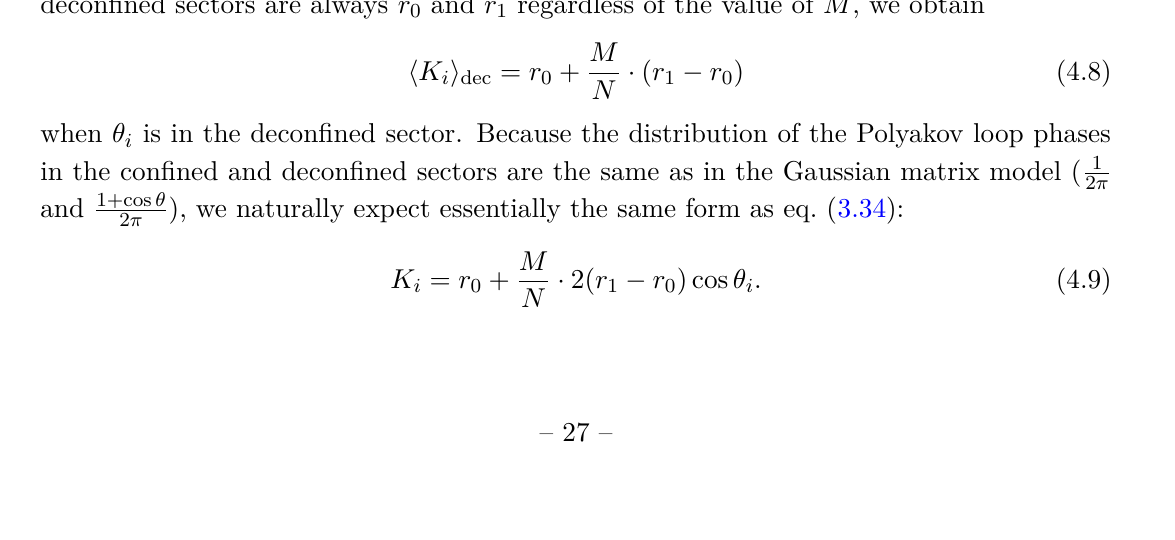
deconfined sectors are always r